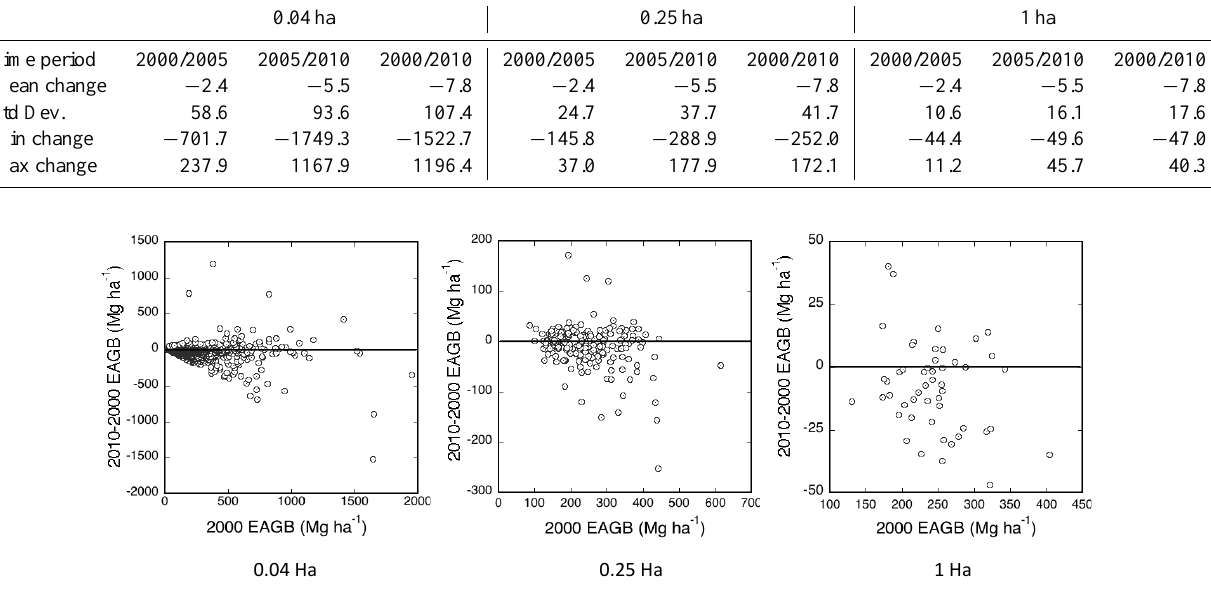
Fig. 3. Ground AGB change between 2000 and 2010 at 0.04ha (left), 0.25ha (center) and 1ha (right). Subplots having high AGB in 2000 are losing